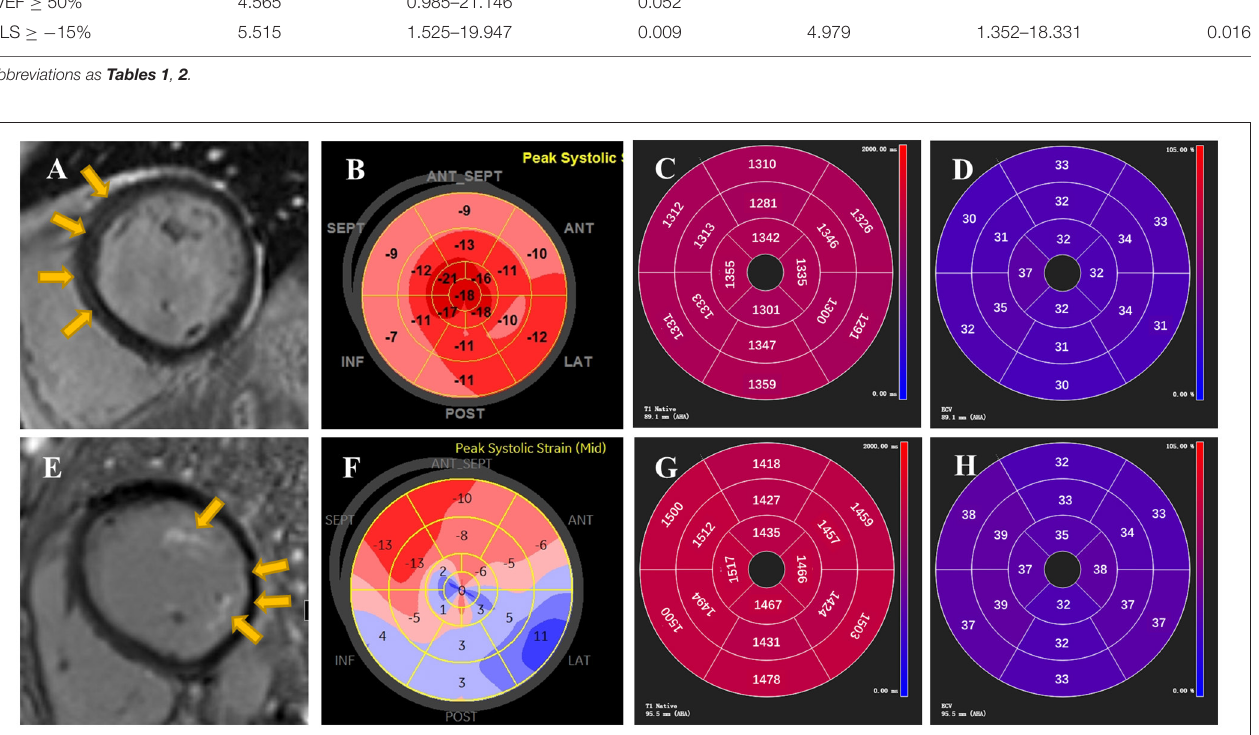
FIGURE 1 | Representative examples of LGE, GLS, native T1 and ECV from two patients with AIDs. On top are demonstrated STE and CMR images of a 44-year-old female patient with tLGEs = 3. LGE showed linear mid-wall enhancement in the septum (A) and Bull’s Eye image from STE presented mild impairment of longitudinal strain in septal longitudinal strain (B) . Global native T1 and ECV were 1,324 ± 23ms and 32 ± 2%, respectively (C,D) . On bottom are reported images from a 51-year-old female patient with tLGEs = 7. CMR showed presence of LGE in left ventricular papillary muscle and lateral wall with a subendocardial pattern (E) . An evident decrease of longitudinal strain in Bull’s Eye image was found in the free wall and apex (F) . Global native T1 and ECV were 1,468 ± 33ms and 35 ± 3%, respectively (G,H) . Yellow arrows indicate the presence of